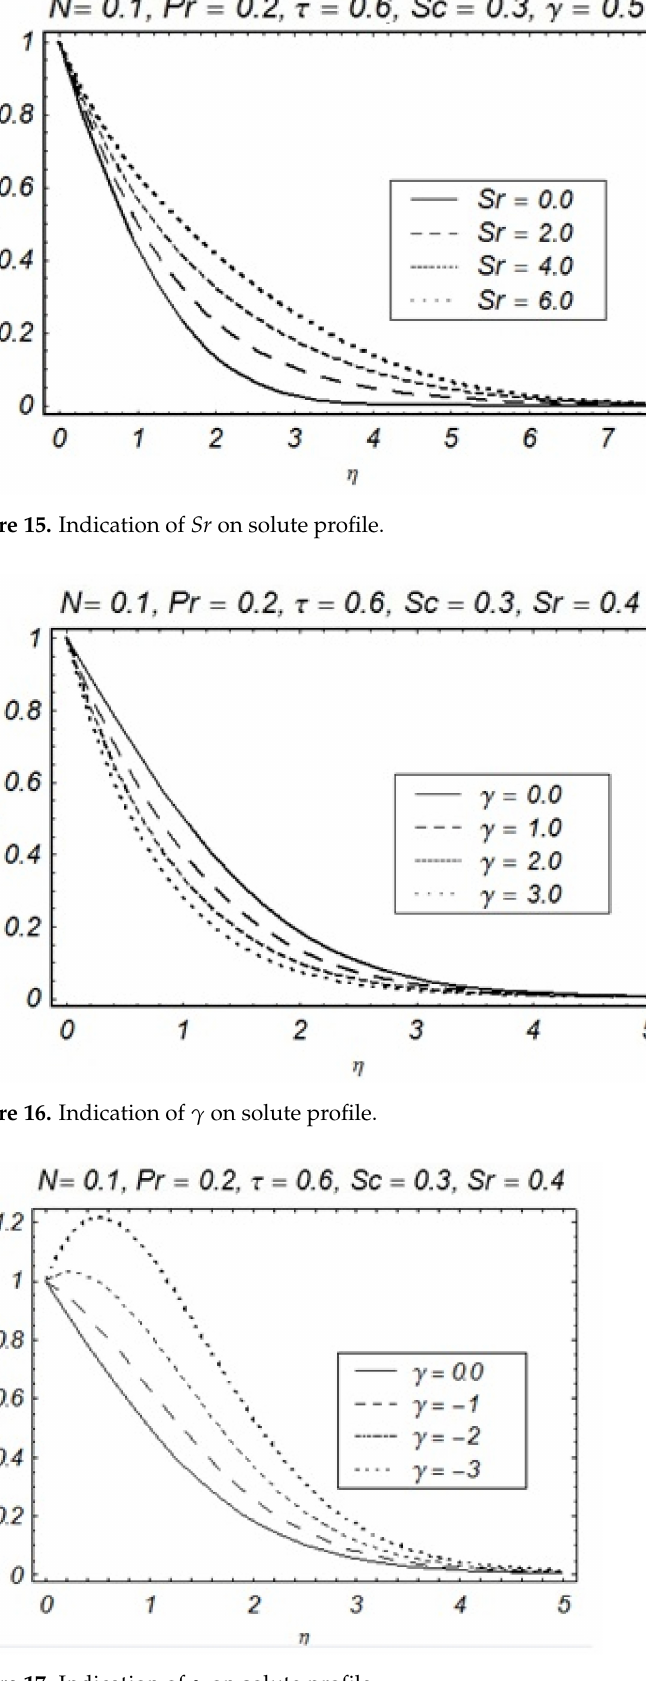
Figure 17. Indication of γ on solute